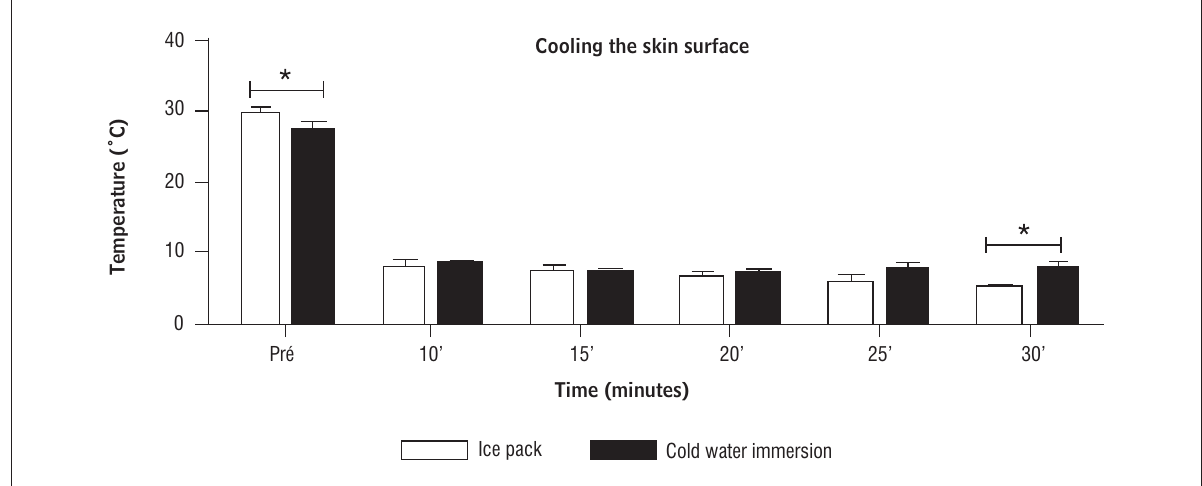
Figure 1 - Mean and standard deviation of the skin temperature over the anterior talofibular ligament of the ankle measured during the application of both cryotherapy methods Note: * P ≤